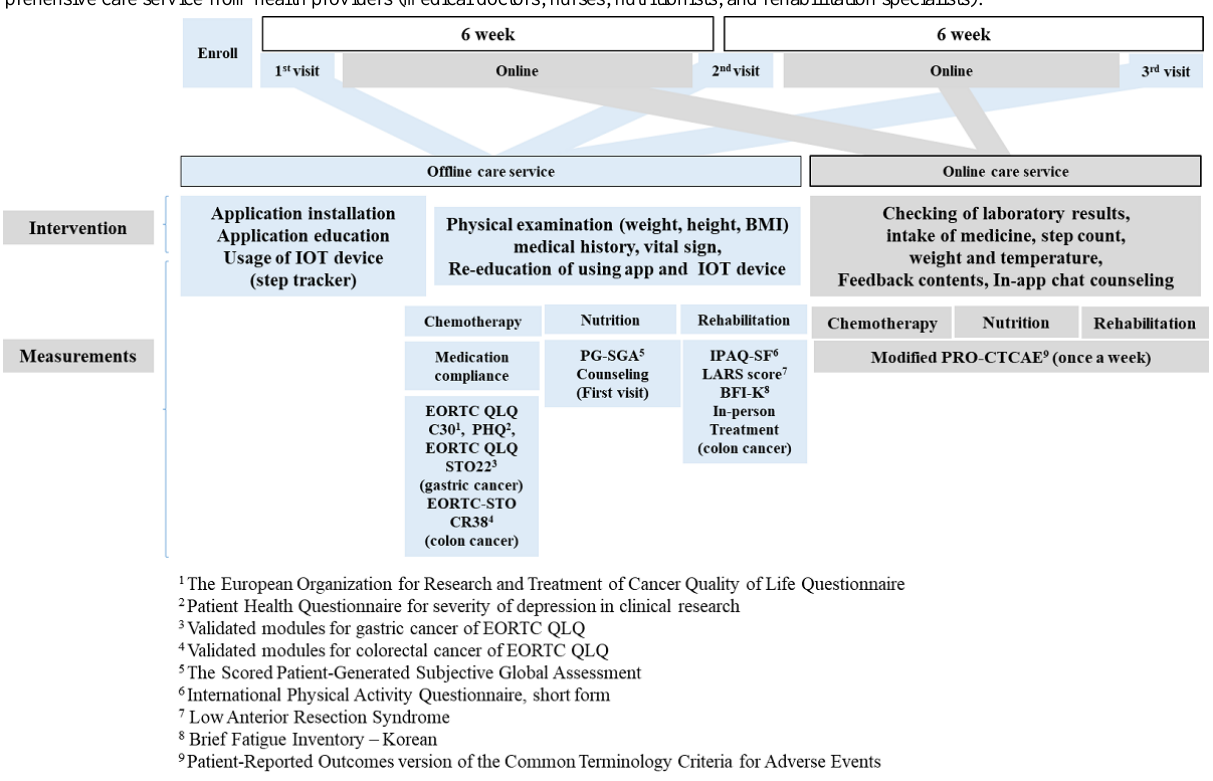
Figure 1. User service diagram. Patients with advanced gastrointestinal cancer are able to use this care service for 12 weeks. The user can receive comprehensive care service from health providers (medical doctors, nurses, nutritionists, and rehabilitation